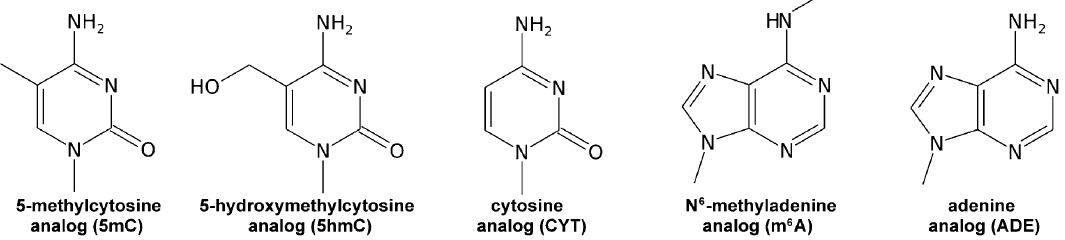
Figure 1. Chemical structures of 5mC, 5hmC, CYT, m 6 A and ADE analogs used in